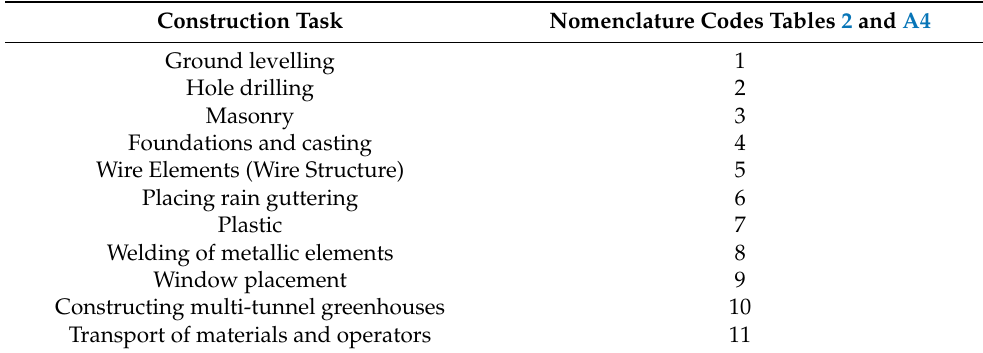
Table A3. Construction tasks of the companies and their nomenclature.